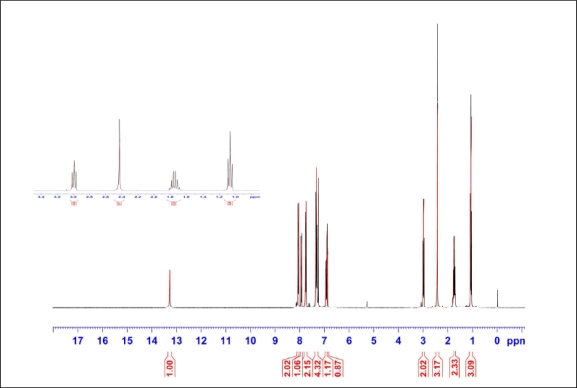
1H-NMR for E-SR3 with expansion for aliphatic protons.